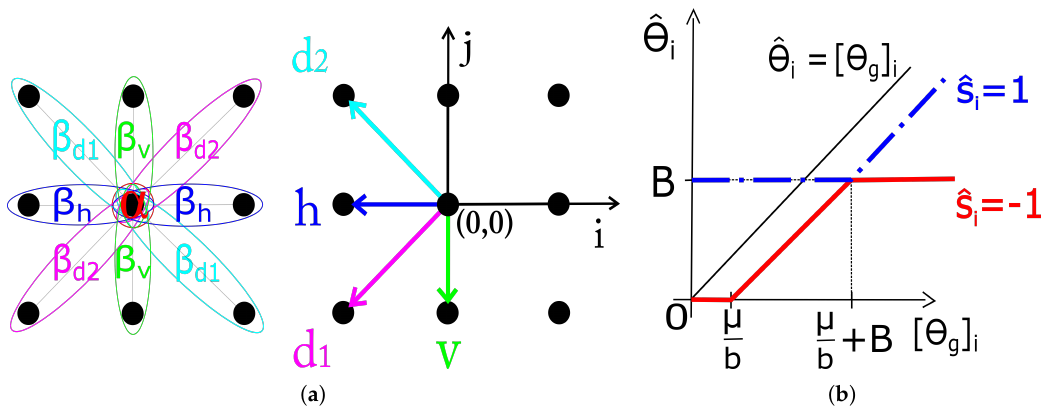
Figure 1. ( a ) Single and pair-site cliques for the second-order neighborhood with parameters and directions used in calculation of R t . ( b ) Soft-thresholding rules for image coefficients [ θ g ] i based on the estimated ˆ s i = { 1, − 1 }